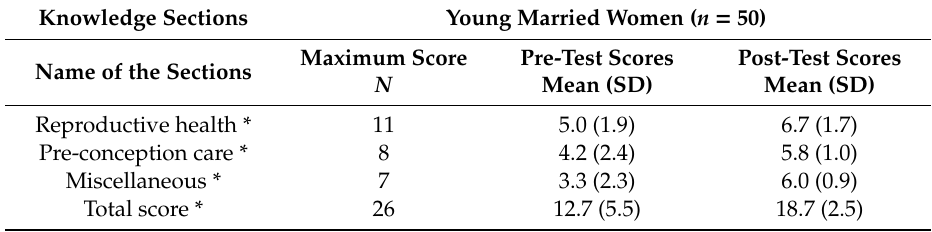
Table 4. Construct validity scores at pre- and post-intervention stage among young married women ( n =